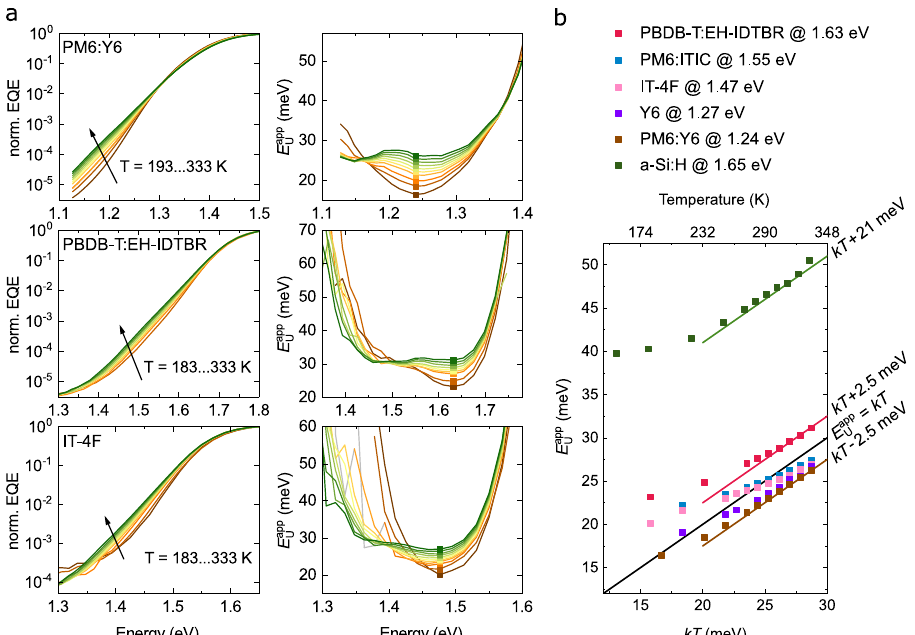
spectra of inverted PM6:Y6, PBDB-T:EH-IDTBR and neat Fig. 3 Temperature dependent apparent Urbach energies. a , Normalized sub-gap EQE and E app U IT-4F solar cells at different temperatures. b , E app as a function of kT for all tested materials systems including a commercial a-Si:H thin- fi lm solar U